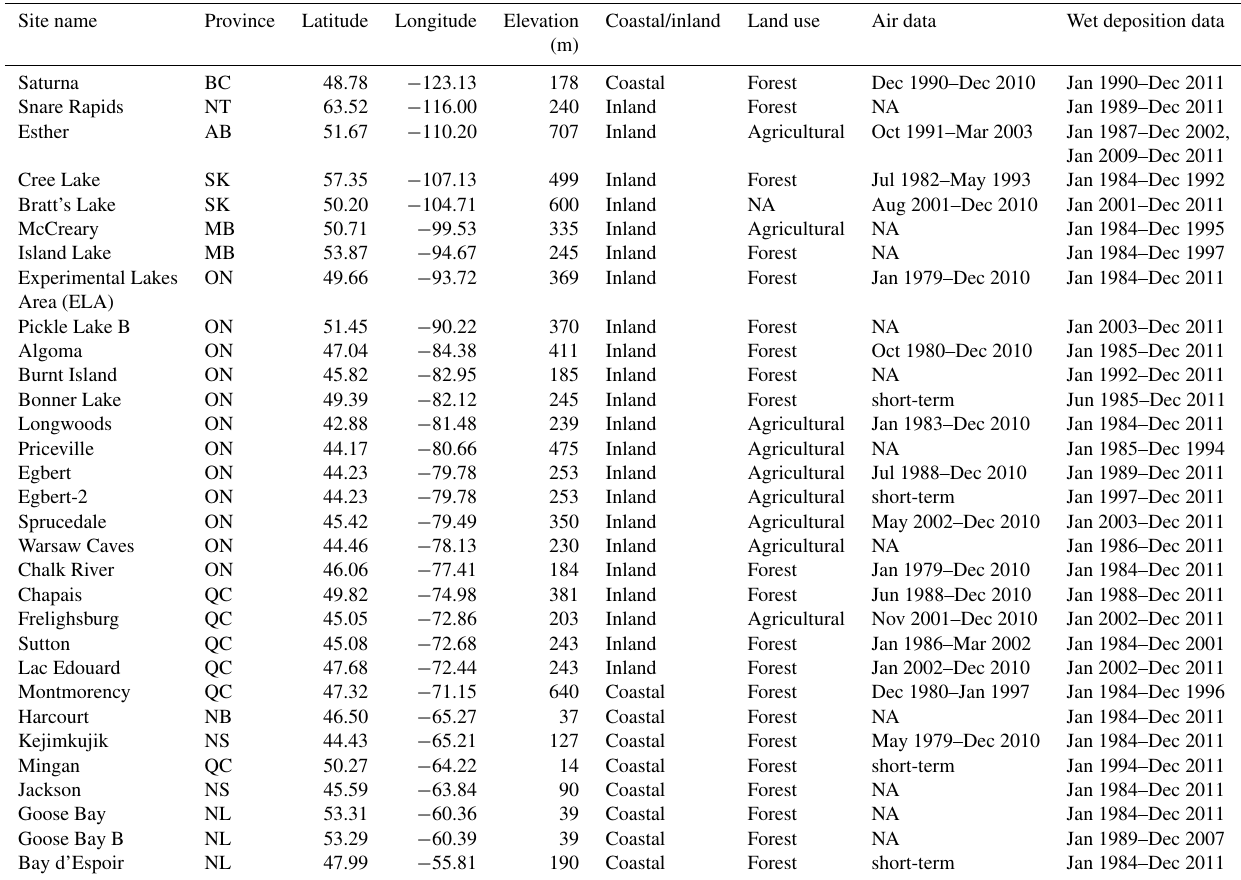
Table 1. Site and data descriptions. NA indicates no available data. Short-term data were not analyzed. Refer to Fig. S1 for a map of the sites. Site